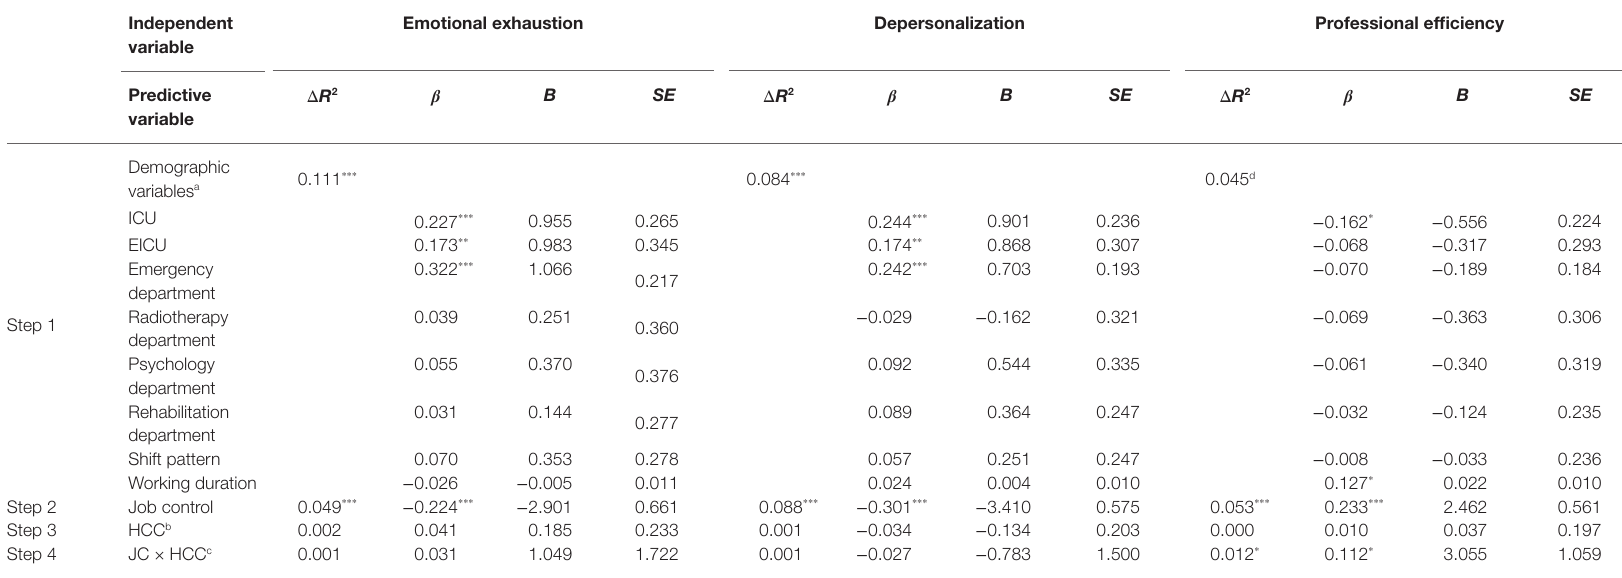
TABLE 2 | Multiple linear regression results of job control, hair cortisol content, and their interaction against job burnouts ( n = 341). Independent Emotional exhaustion Depersonalization Professional variable